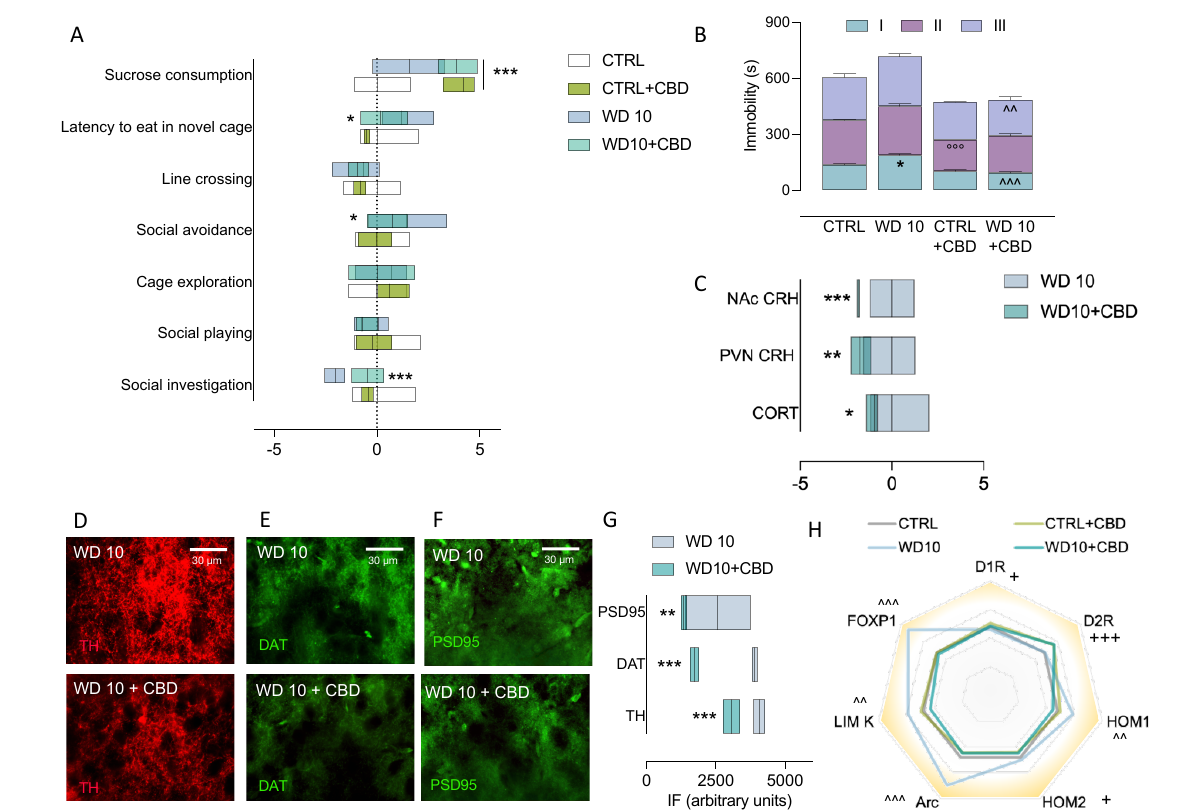
Figure 6. CBD rescues behavioural, neuroendocrine and NAc neuroplasticity maladaptations in binge-like alcohol-exposed rats. Sub-chronic CBD administration during withdrawal ( A ) increased social investigation (*** p < 0.001) and decreased both social avoidance (* p < 0.05) and latency to eat in the novel arena (* p < 0.05) in binge-like alcohol exposed rats; in addition, it increased sucrose consumption in both WD10 and CTRL rats (*** p < 0.001). Moreover ( B ) the passive coping observed at WD10 (* p < 0.05) was counteracted by CBD (ˆˆˆ p < 0.001), which also decreased immobility in CTRL rats within the second time bin ( ◦◦◦ p < 0.001) and in WD10 rats during the last time bin (ˆˆ p < 0.01). As for HPA-axis alterations due to binge-like alcohol exposure during adolescence, ( C ) CBD decreased serum CORT levels (* p < 0.05) and CRH immunopositivity in the PVN (** p < 0.01) and the NAc ( p < 0.001) in WD10 rats. In addition, CBD was able to counteract the effects of binge-like alcohol exposure during adolescence on neuroadaptations of DA and glutamate signaling in the NAc, with reference to ( D , G ) TH-positive immunofluorescence, ( E , G ) DAT immunopositivity and ( F , G ) PSD95 immunofluorescence, and in terms of gene the expression of ( H ) D1R (+ p < 0.05); D2R (+++ p < 0.001); HOM1 (ˆˆ p < 0.01); HOM2 (+ p < 0.05); Arc (ˆˆˆ p < 0.001), LIM Kinase 1 (ˆˆ p < 0.01); FOXP1 (ˆˆˆ p < 0.001). CBD: cannabidiol; WD10: withdrawal day 10; CTRL: water-exposed control group; PVN paraventricular hypothalamic nucleus; NAc: nucleus accumbens; CORT: corticosterone; CRH: corticotropin releasing hormone; TH: tyrosine hydroxylase; DAT: dopamine transporter; PSD95: post synaptic density protein 95; D1R: dopamine receptor 1; D2R: dopamine receptor 2; HOM1: Homer 1; HOM2: Homer 2; Arc: activity regulated cytoskeleton-associated protein; LIM K: LIM domain Kinase 1; FOXP1: Forkhead box P1. Each box represents the mean (line) and the range values of n = 7 rats; each bar represents the mean of n = 7 rats, and error bars indicate SEM. Unless differently indicated, boxes and lines in radar graph represent standardized values, cantered at zero for the CTRL